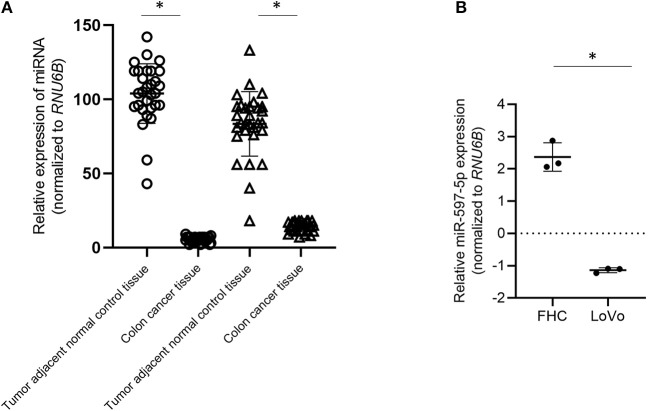
Down regulation of MiR-597-5p in colon cancer cells. (A) qRT-PCR analysis of miR-597-5p and miR-143-5p using RNA isolated from 30 paired cancer and tumor adjacent normal colon tissue specimens. (B) qRT-PCR analysis of miR-597-5p in LoVo and FHC cells (normal colonic epithelium). Data in (A,B) were normalized based on RNU6B expression. Data expressed as mean ± SD of three independent experiments. *P < 0.05.